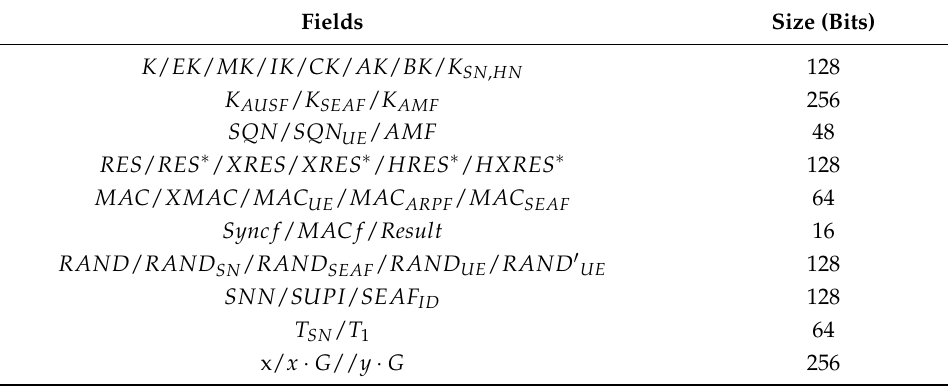
Table 2. The sizes with respect to numerous fields of the transmitted messages [2–4,26,27]. Fields Size